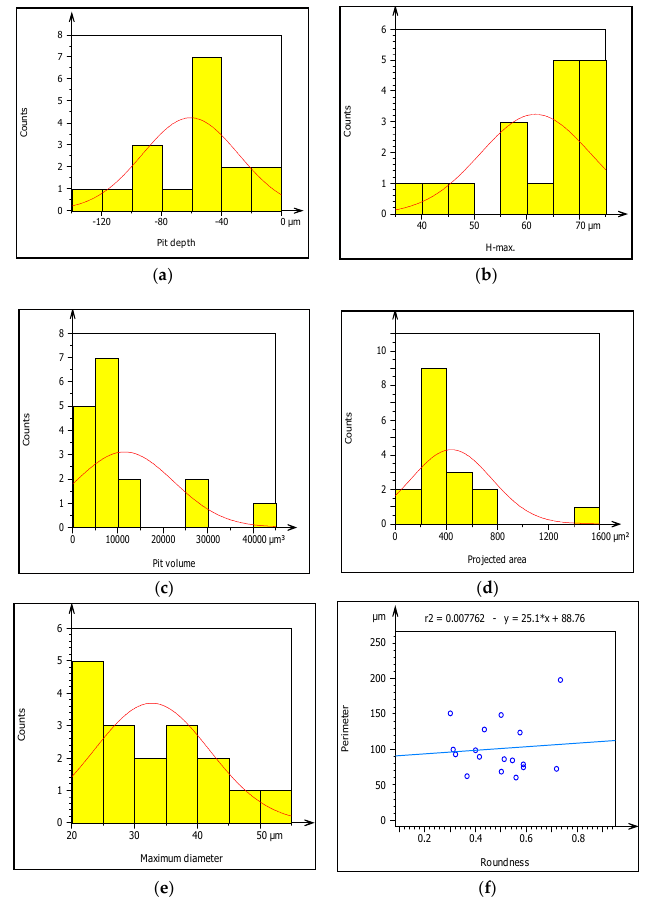
Figure 10. ( a – f ) Characterization of pitting corrosion results obtained from galvanized steel pipe.